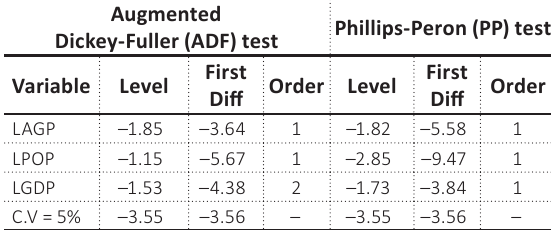
Table 2. Results of unit root